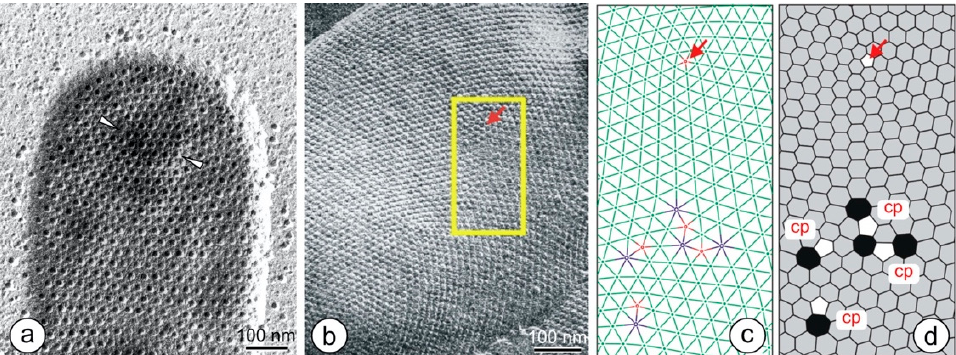
Figure 8. TEM images of freeze-etched and metal shadowed preparations of ( a ) Th. tenax and ( b ) M. sinense . In ( a ), the hexagonal S-layer lattice was highlighted by labeling each morphological unit with a polycationic ferritin (PCF) molecule. Arrows indicate local +60° wedge disclination in the hexagonal S-layer lattice (reproduced with permission from Reference [69]; published by the Amer- ican Society for Microbiology, 1986). ( c ) Relative to the marked area in ( b ), hexagonal lattice posi- tions are shown in green, five-fold positions (+60° wedge disclinations) in red, and the seven-fold positions ( − 60° wedge disclinations) in blue. In ( d ), hexagons, pentagons, and heptagons are shown as Voronoi cells. Pentagon–heptagon pairs are called complementary pairs and are considered ini- tiation points for the incorporation of new S-layer proteins into the S-layer lattice of the growing archaeal cell (( b , c ) reproduced with permission from Reference [84]; published by the American Society for Microbiology, 1991).